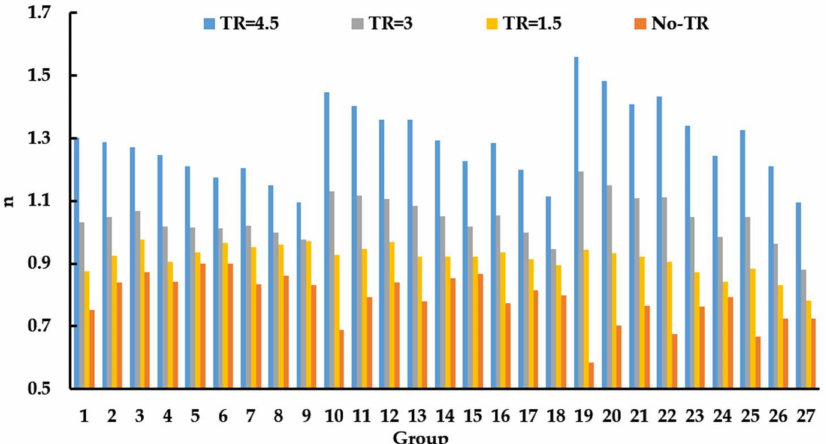
Figure 5. Comparison of the coefficient n of the two